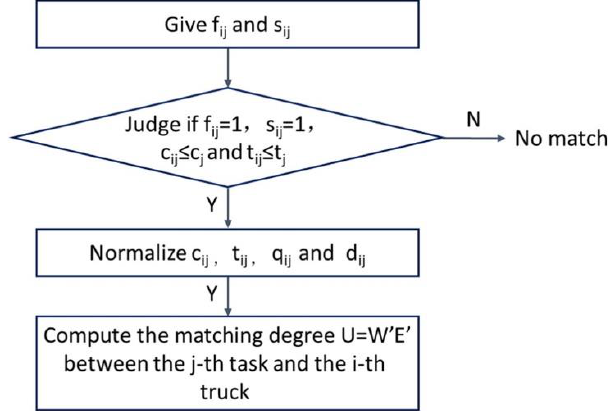
Figure 1. Algorithm of the truck and task connection.